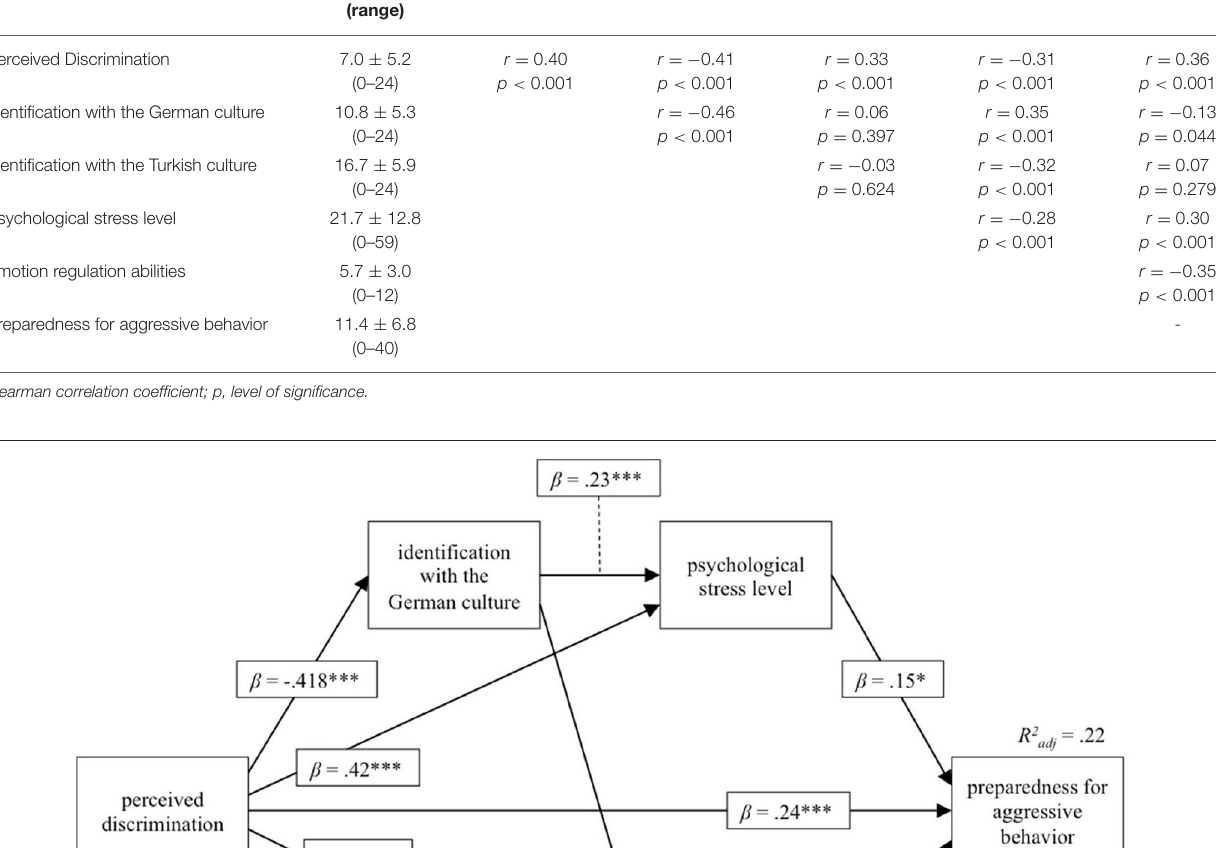
TABLE 2 | Zero-order correlations between Perceived Discrimination as well as the predictor variables and potential confounding variables. Variable